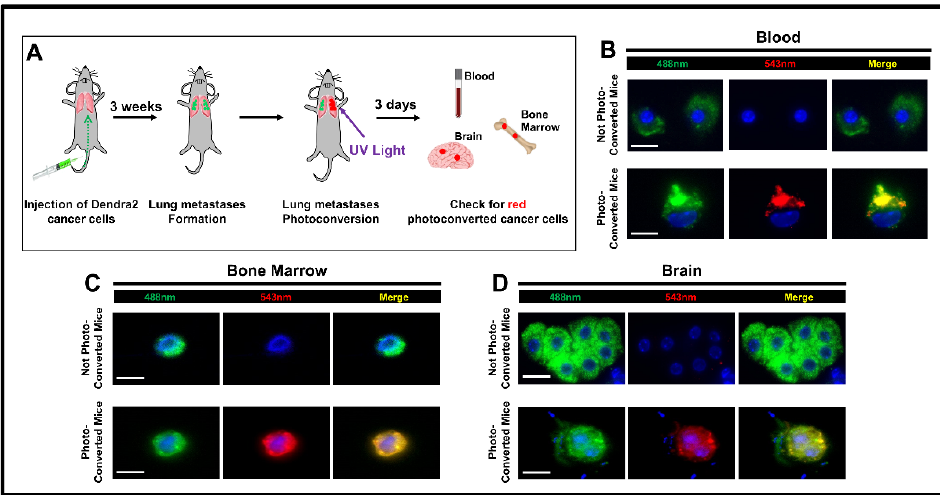
Figure 1. Cancer cells disseminate from lung metastases to tertiary sites. ( A ) Experimental design. E0771 Dendra2-expressing cancer cells are injected into the tail veins of C57BL mice to generate lung metastases. Approximately three weeks later, lung metastases are exposed to UV light for photoconversion. Three days after photoconversion, blood, brain, and bone marrow were collected and analyzed for the presence of red-fluorescent cancer cells. ( B – D ) Representative images of cancer cells detected in the blood, brain, and bone marrow of mice. Top panels are images of disseminated cancer cells (DCCs) with non-photoconverted Dendra2 (note green-fluorescence) from control mice (no photoconversion), whereas the bottom panels show images of DCCs from mice with photoconverted lungs (note green- and red-fluorescence). Scale bar 10 μ m.